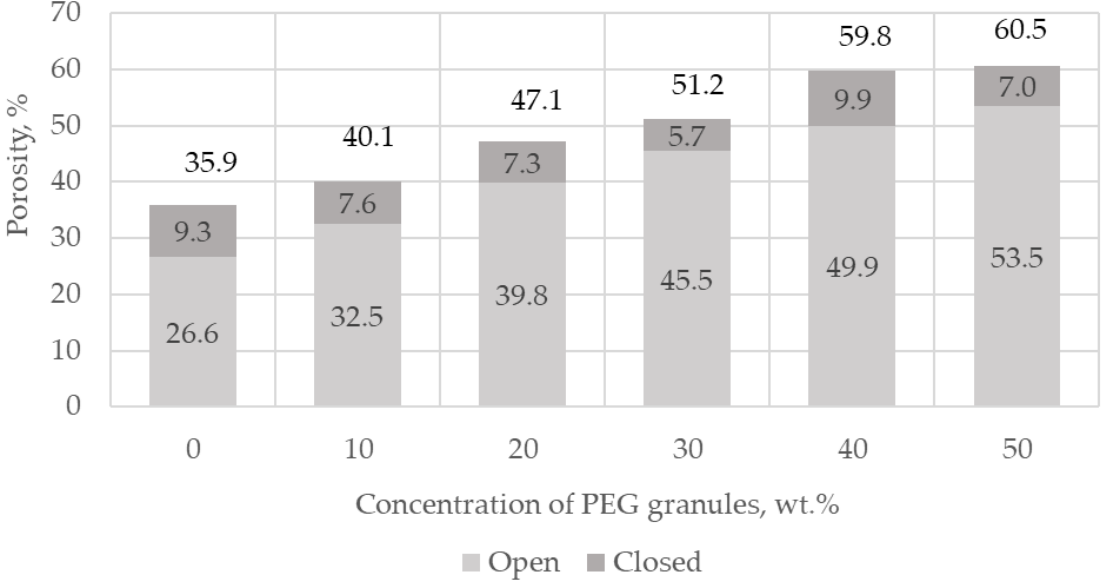
Figure 5. Porosity of ceramics.